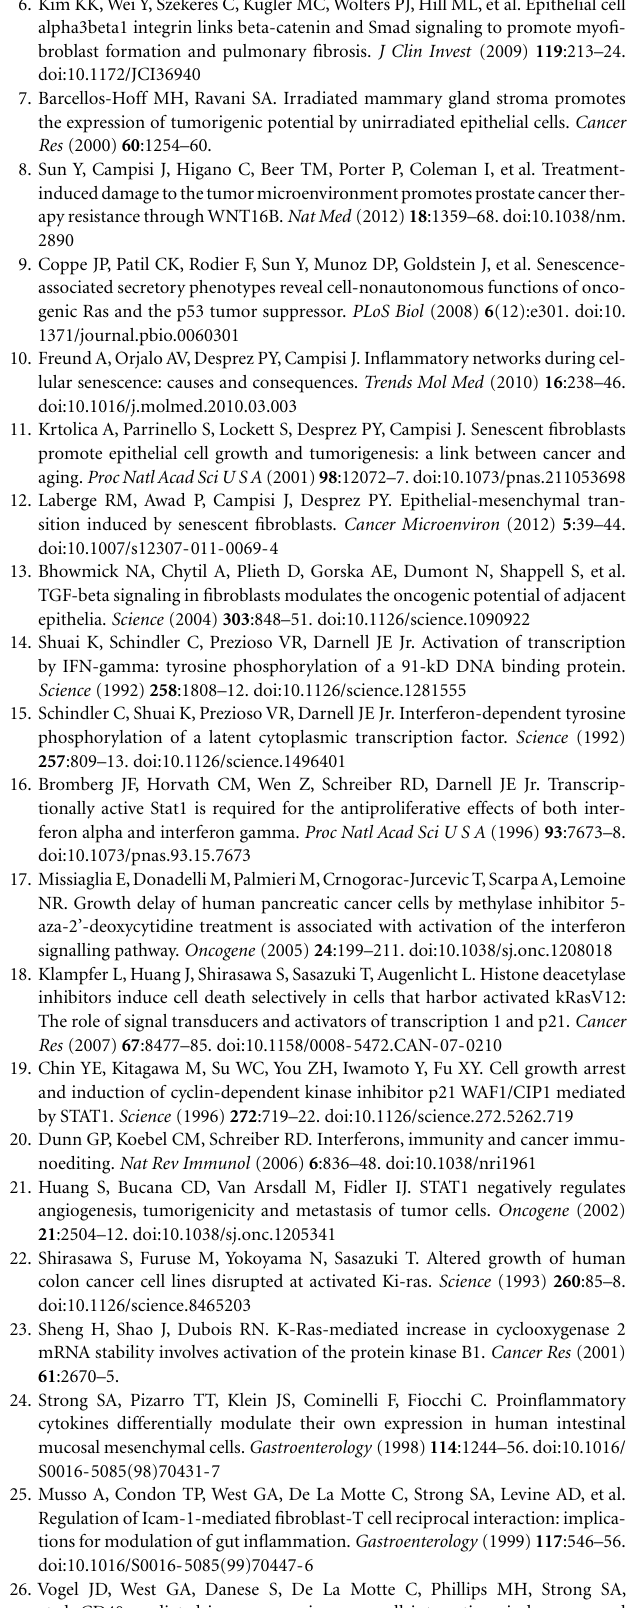
Figure S1 | Fibroblast-derived factors inhibit growth of rat intestinal cells. Rat IEC-iKRasV12 cells were left untreated or were induced by IPTG to express mutant K-Ras.The cells were cultured in the absence (CTRL) or the presence of 30 or 50% of conditioned medium from rat MIC216 intestinal fibroblasts. Cell growth was monitored by the MTT assay (A) or BrdU incorporation (B) .The inhibitory effect of MIC216 cells was confirmed by co-culturing of IEC-iKRasV12 and MIC216 cells using transwells (C) and by demonstrating the reduced levels of cyclin D1 (cyclD1) in intestinal cells grown in the presence of MIC216 fibroblasts (D) . NSB, non-specific